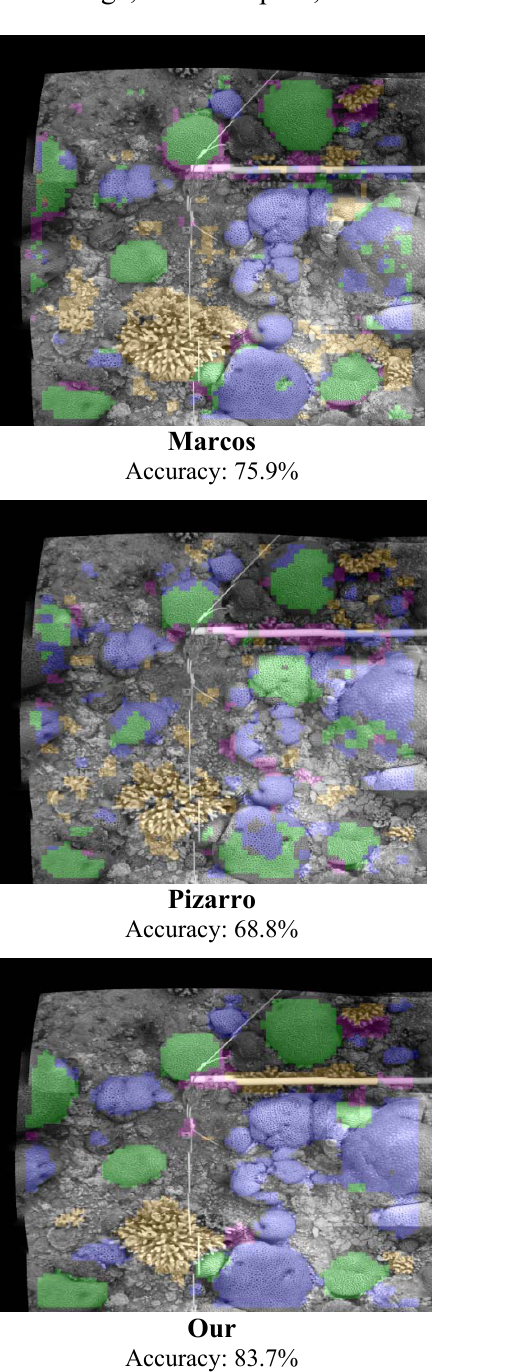
Figure 7. The accuracy of the tested classification methods applied to the Red Sea mosaic. The segmented images are color coded as: favid in violet, brain coral in green, branches I, II and III in orange, urchin in pink, dead corals and pavements are in